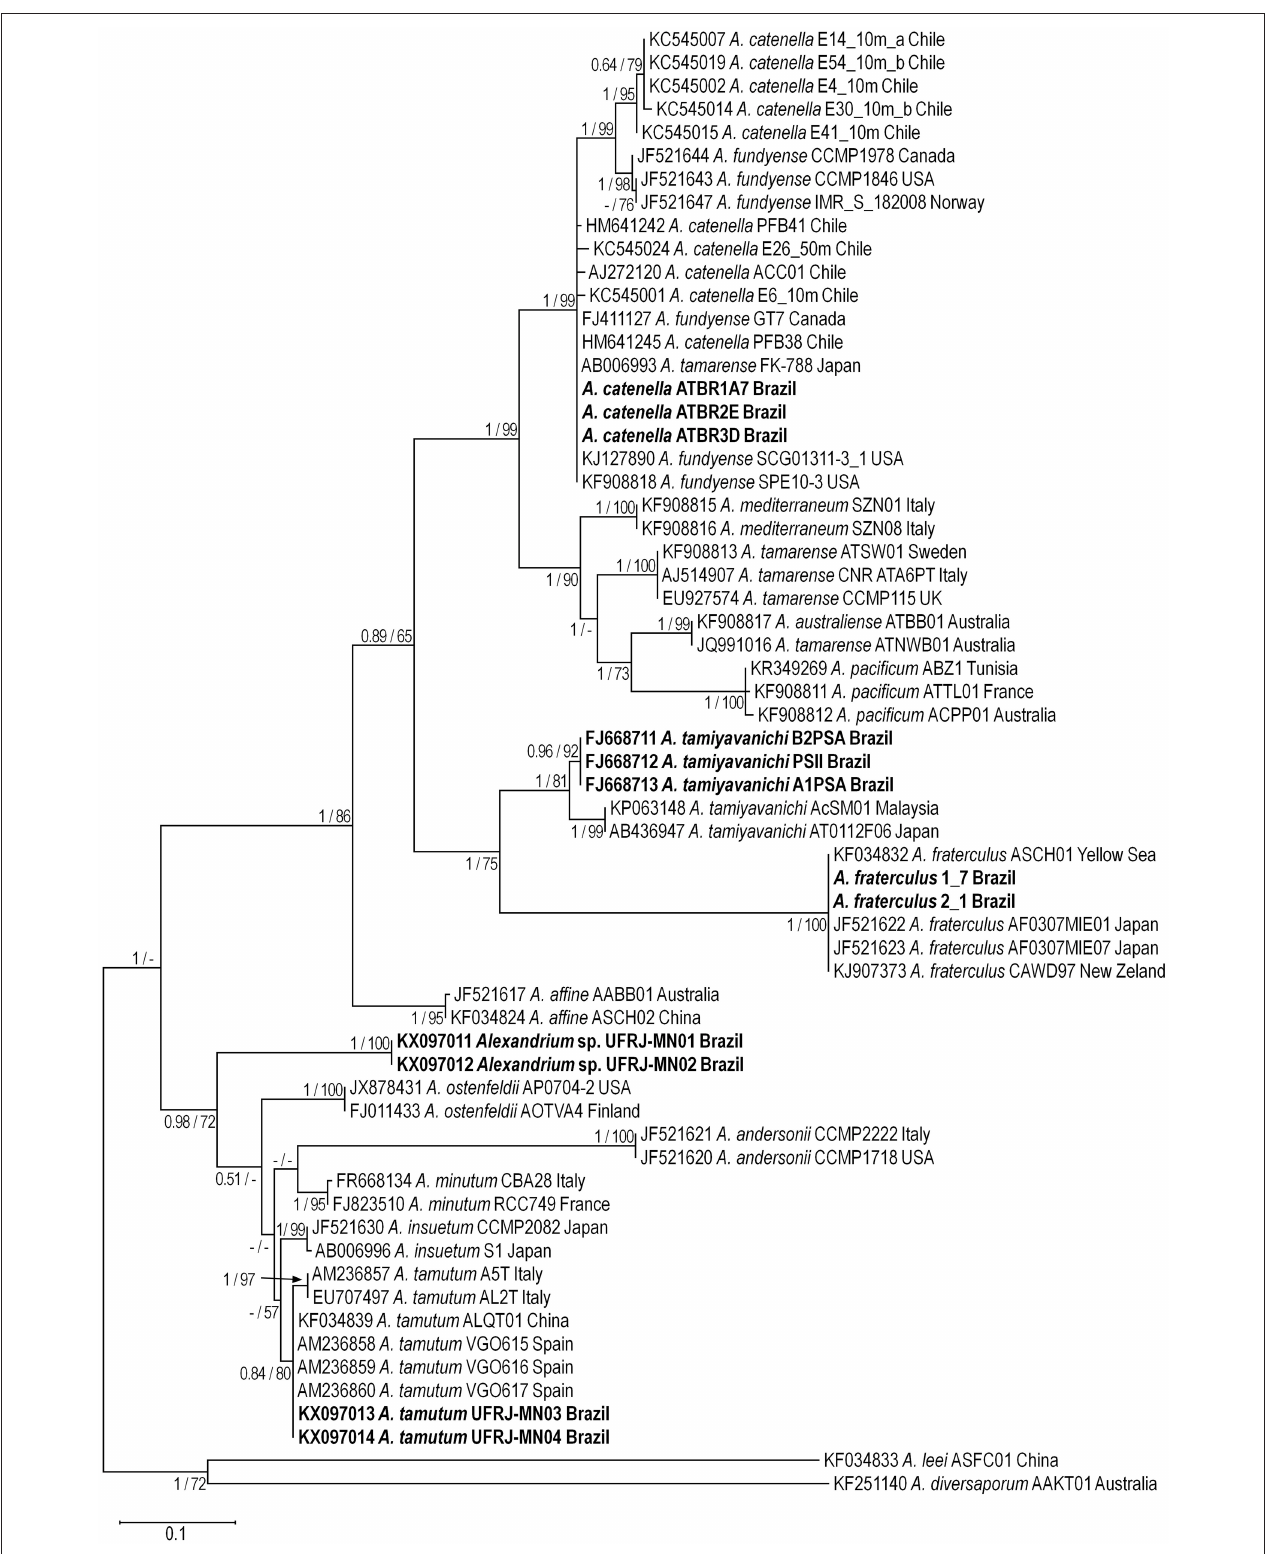
FIGURE 4 | Maximum Likelihood tree based on ITS rDNA sequences. Alexandrium sequences from Brazil are shown in bold. Numbers at nodes are bootstrap and posterior probabilities values for Maximum Likelihood and Bayesian Inference analysis, respectively. Only values > 50% (ML) and 0.50 (BI) are shown.